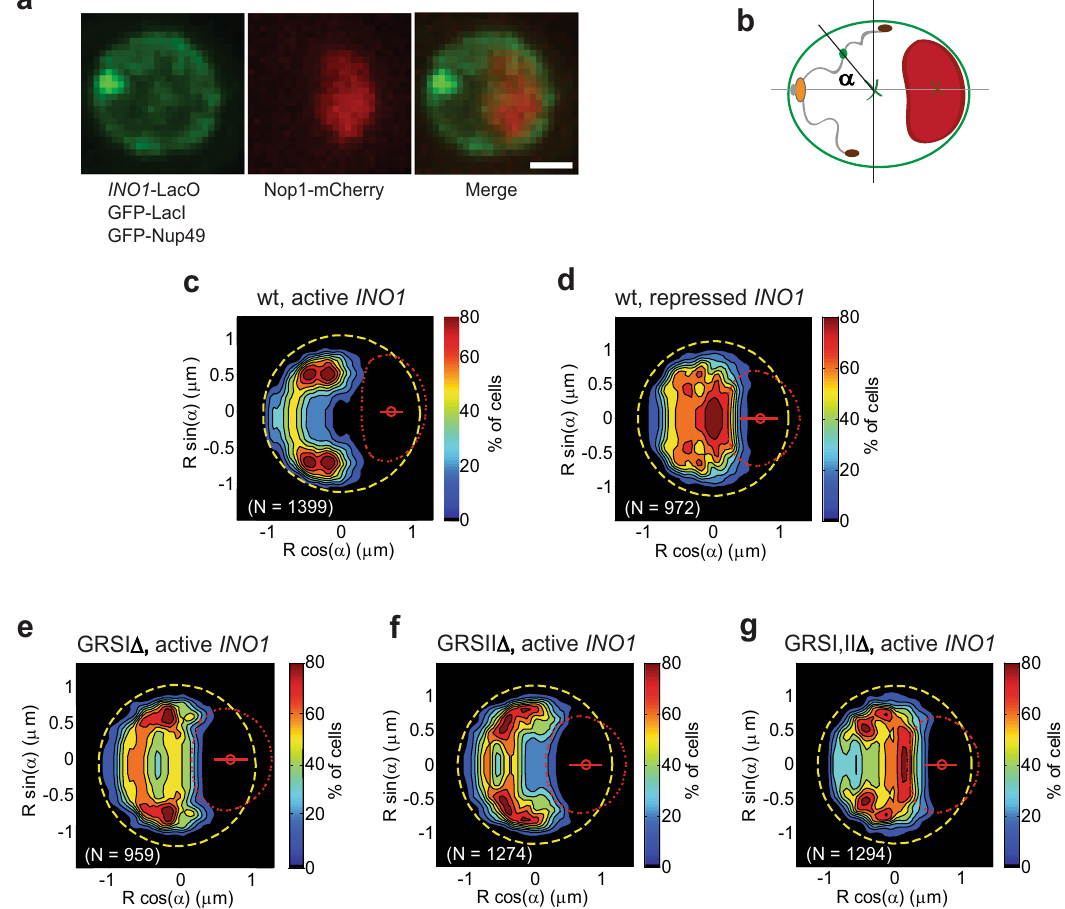
Fig.1|Activated INO1 NElocalizationisdisruptedbythedeletionofbothGRSI and II. a Representative photomicrographs of yeast nuclei containing the LacO repressor array integrated into the INO1 locus and expressing GFP-LacI allows for visualization of dynamics in the locus with GFP-Nup49-labeled NE and Nop1- mCherry-labeled nucleolus as spatial reference markers (maximum projection of 250nm Z stacks). Scale bar represents 1 µ m. These results are representative of threeindependentexperiments. b Yeastnucleuslandmarksused ascoordinatesfor this analysis. NE (green ellipsoid), nucleolus (red ellipsoid) and nucleus center (greenx).Thegraylinesrepresentthecentralaxesoftheellipsoid; α ,anglefromthe